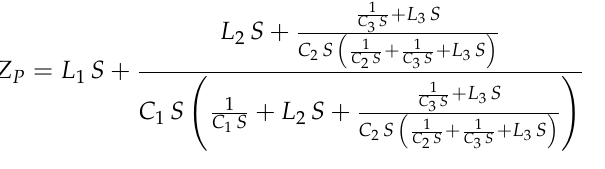
Figure 5. Magnitude of the extracted transfer function H ( S ). After obtaining the LCEC of the initial resonator, the microstrip transmission line realization can be achieved. The layout structure and frequency response of the initial horizontal resonator is depicted in Figure 6a,b. Port 1